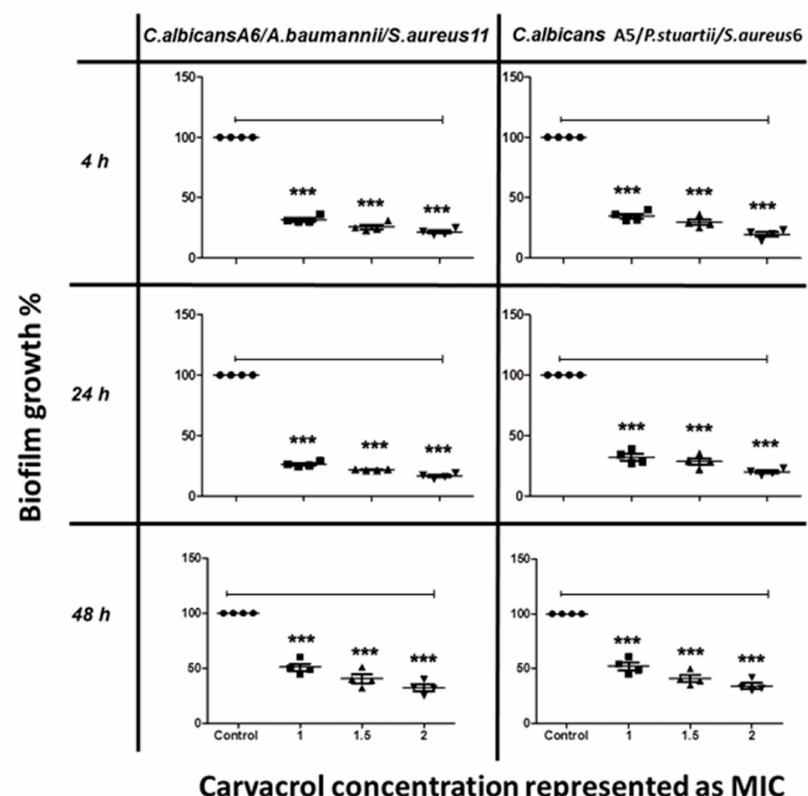
Figure 3. The inhibitory e ff ect of carvacrol on C. albicans / bacteria in mixed biofilm formation at di ff erent time points, as determined by MTT viability assays. C. albicans cells were allowed to adhere onto 96 well microtiter plates at time points of 4 h, 24 h, and 48 h, followed by treatment with various concentrations of carvacrol at 1.0, 1.5, and 2.0 MIC prior to incubation at 37 ◦ C. The anti-biofilm activity of the compound was assessed by measuring the metabolic activity of viable cells by MTT assay. The data were analyzed using one-way ANOVA and statistical significance was calculated with Dunn (cid:48) s multiple comparison test. Significance level is indicated by asterisks. The data display the mean ± standard error (SEM) of four